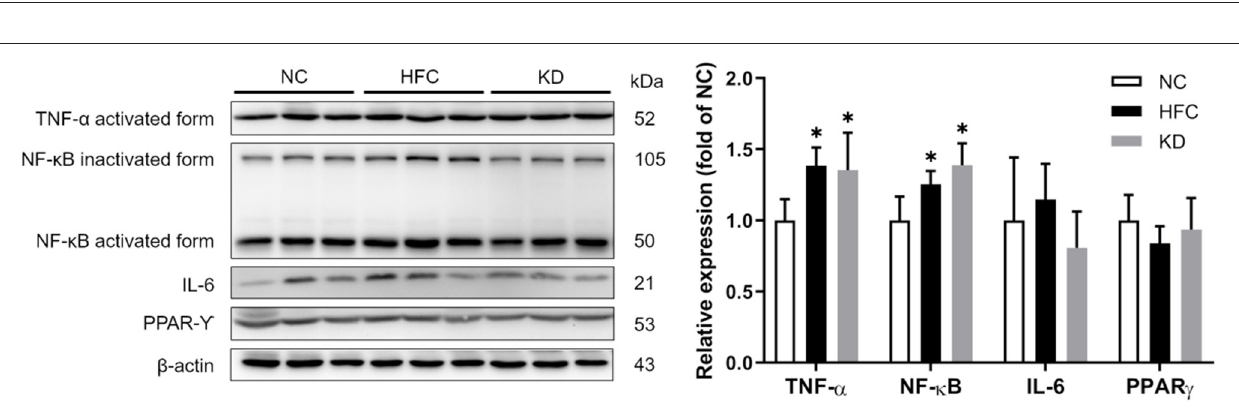
group, suggesting that the conversion of androstenedione to testosterone was blocked